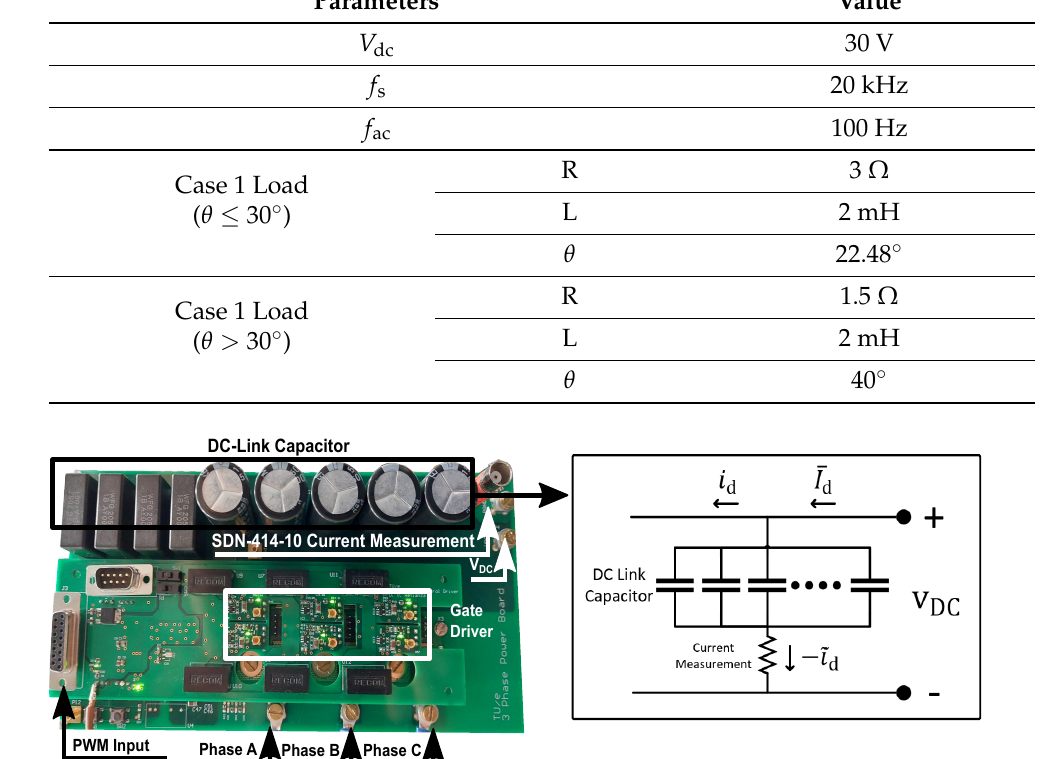
Figure 11. Experimental setup for the three-phase